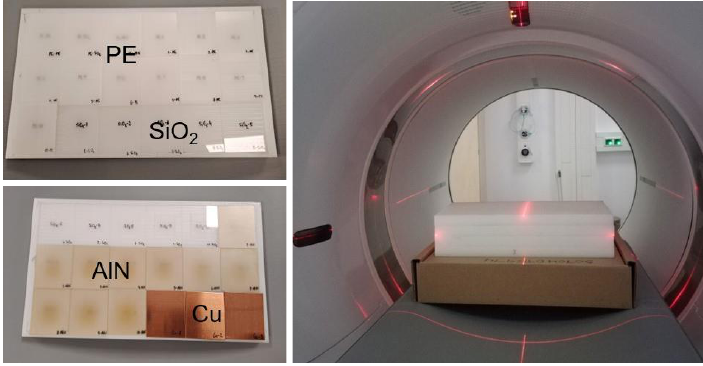
Figure 3 . PET/CT measurement of the irradiated foils embedded between polyethylene